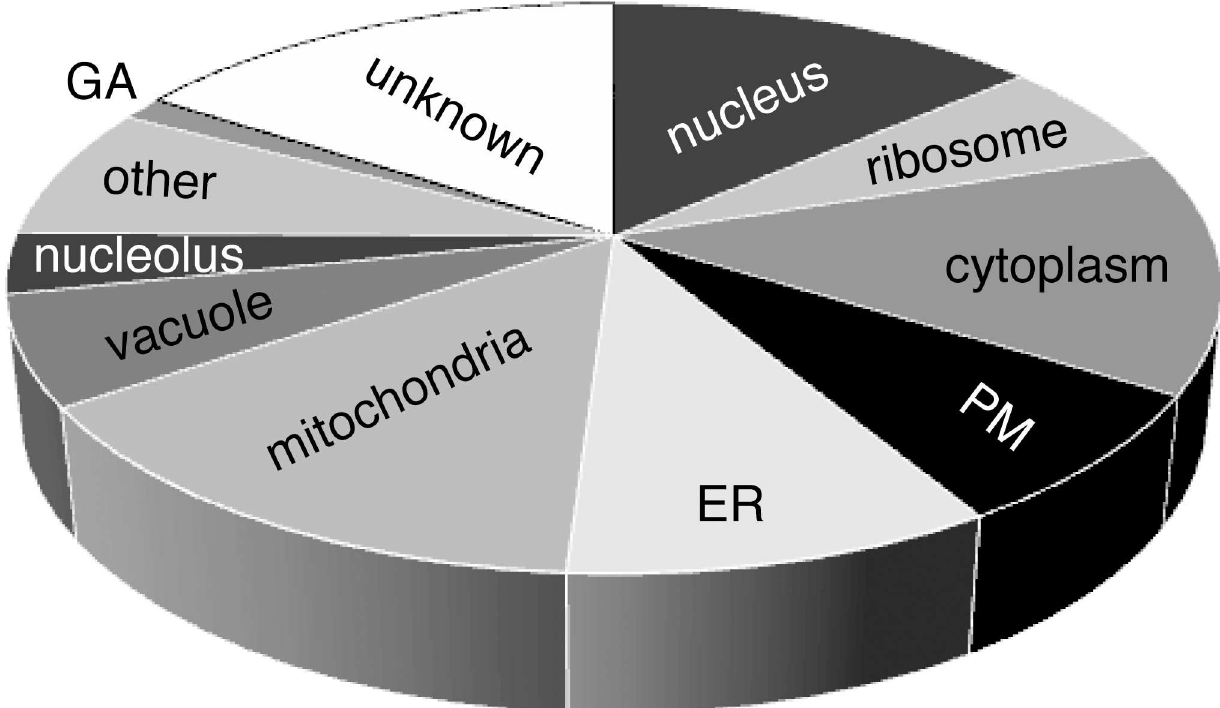
Fig 3. Distribution of localization of the proteins encoded by the genes whose deletion results in altered sensitivity to valinomycin and/or nigericin (see Table 3 for details). Proteins with dual localizationare counted twice (once for every localization) to reflect here every occurrenceof the proteins in the